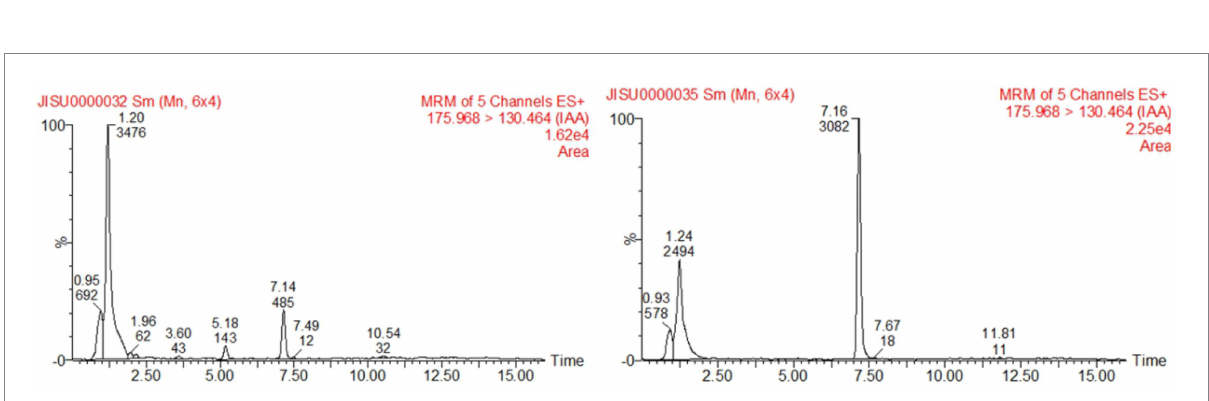
FIGURE 6 Detection of IAA production by UPLC. The left figure shows the sample of the control, and the right shows the sample of B. aryabhattai LAD culture cultivated with maize